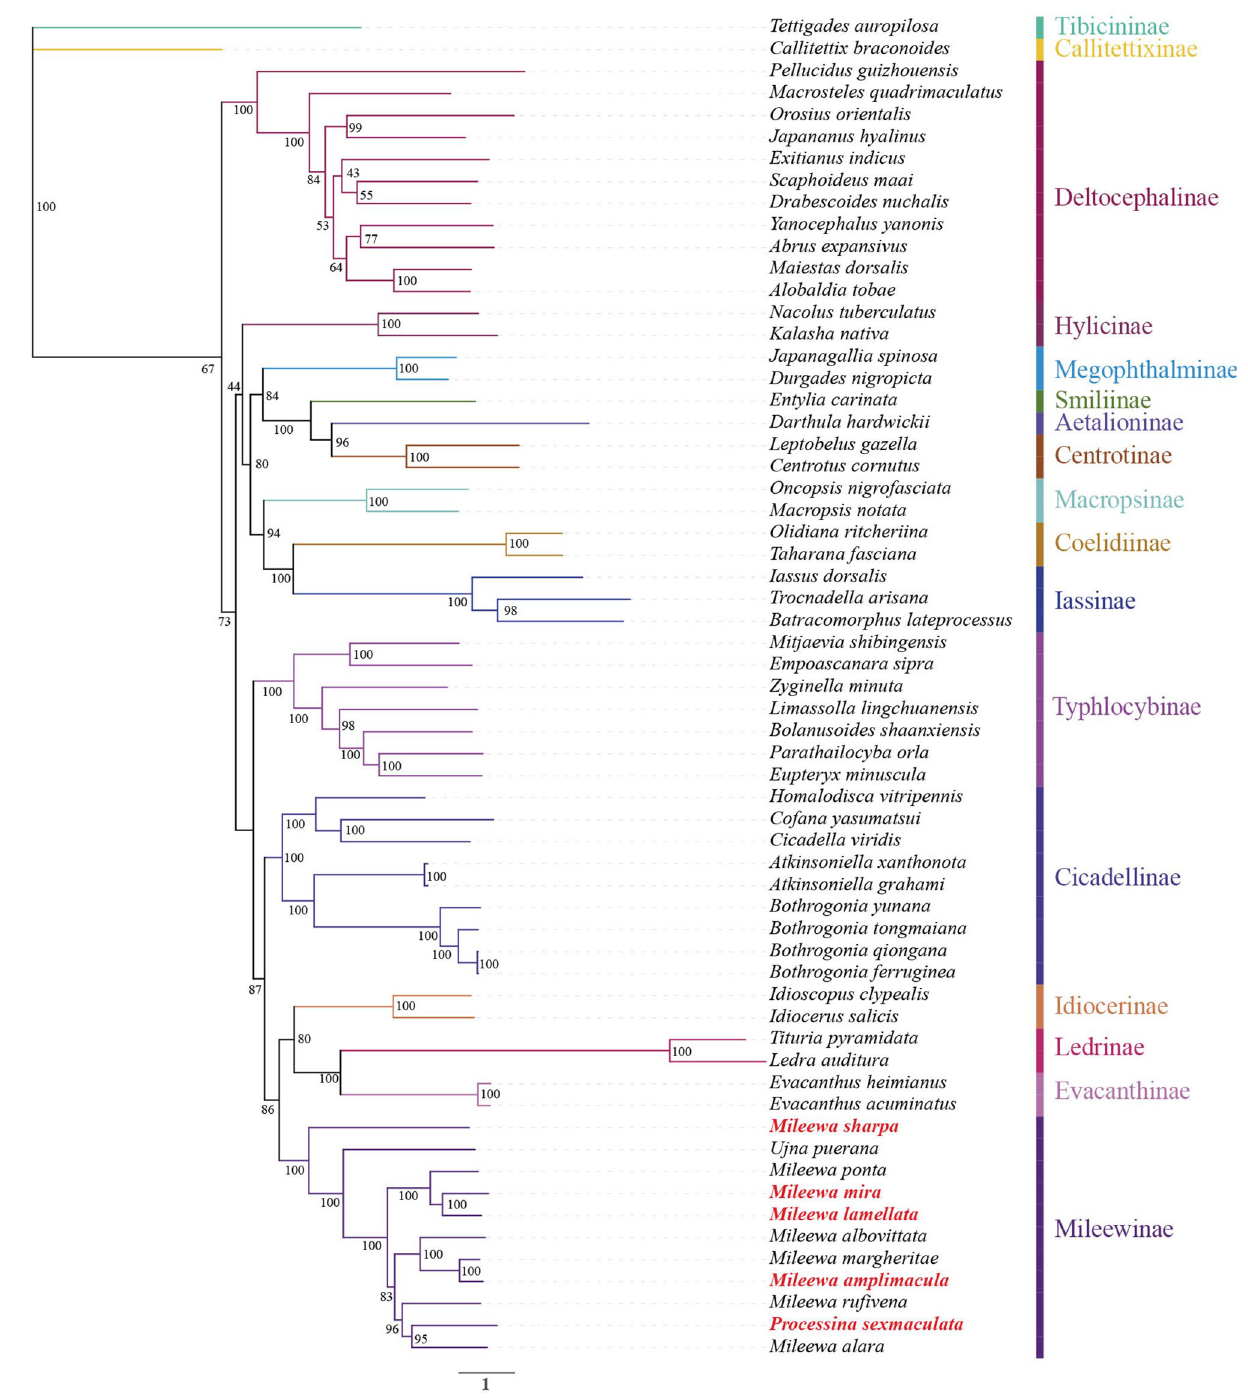
Figure 3. Maximum likelihood (ML) phylogenetic tree analysis of 13 protein-coding genes (PCGs). Callitettix braconoides and Tettigades auropilosa are outgroups. Bootstrap support (BS) values are shown at the nodes. Newly sequenced mitogenomes are indicated in